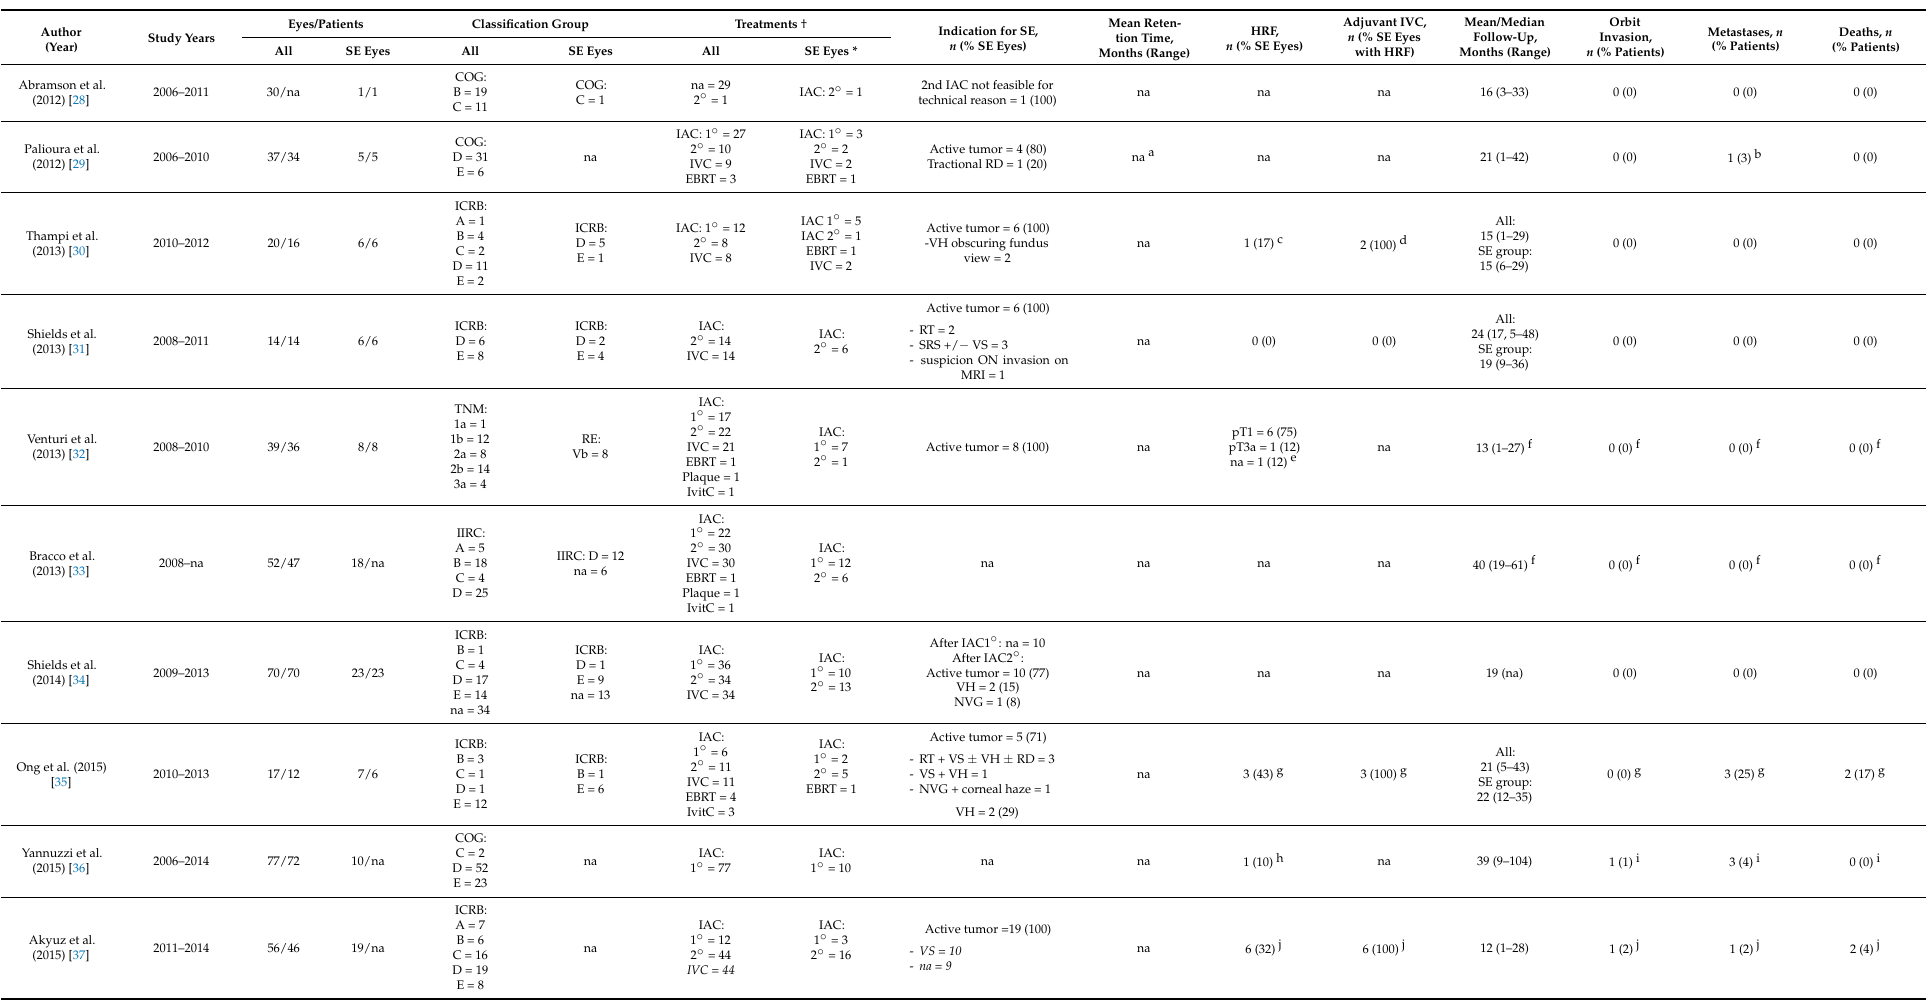
Table 3. Secondary enucleations (SE), orbital invasion, metastases and mortality rates after first line (1 ◦ ) or salvage intra-arterial (2 ◦ ) chemotherapy (IAC): literature